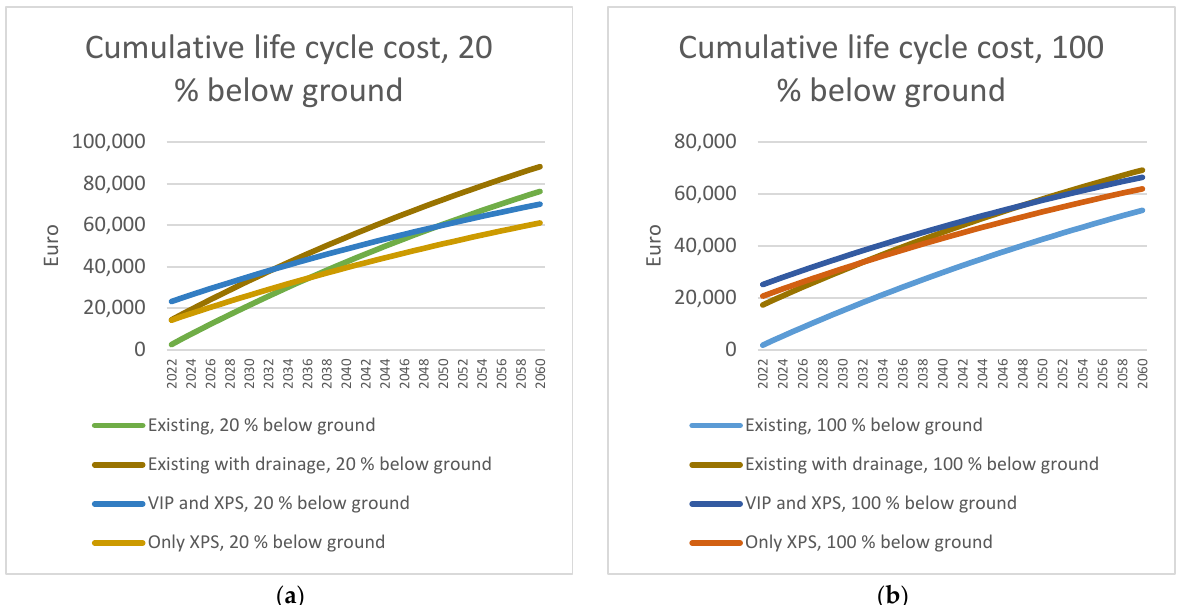
Figure 9. ( a ) The cumulative life cycle cost for four alternatives with 20% of the basement below ground (no upgrade, only drainage, upgrade with VIP and XPS, and upgrade with only XPS). Values in Euro; ( b ) The cumulative life cycle cost for four alternatives with 100% of the wall below the ground (no upgrade, only drainage, upgrade with VIP and XPS, and upgrade with only XPS). Values in Euro.